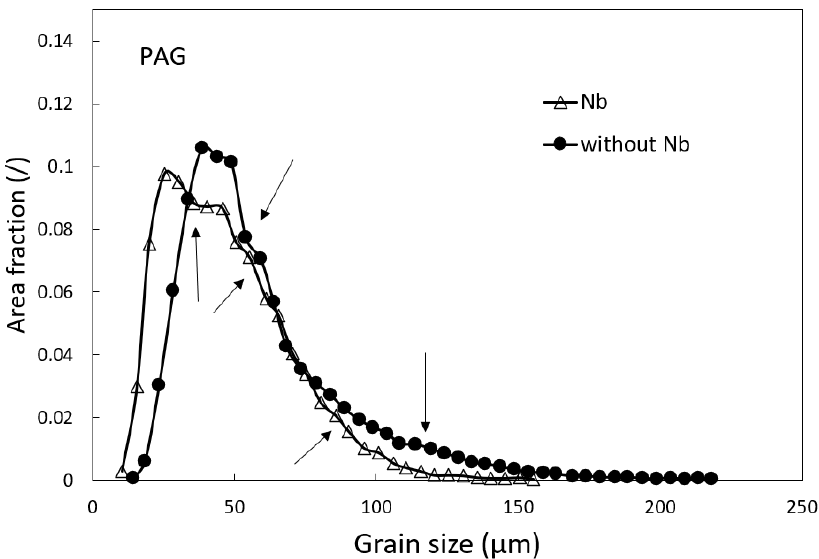
Figure 9. Frequency distribution of predicted PAG with obvious multimodality (highlighted with arrows).